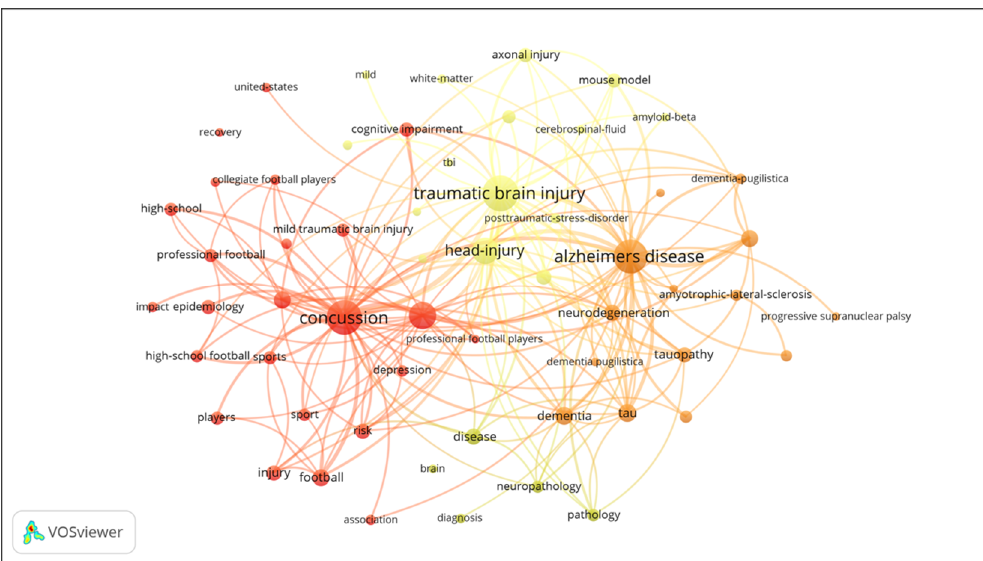
Figure 9. The cluster view of high frequency keywords in the CTE research field from 1999 to 2019. Each color in the figure represents a category, and keywords with the same color belong to the same cluster. The keyword “chronic traumatic encephalopathy” was excluded from our search for an improved understanding.